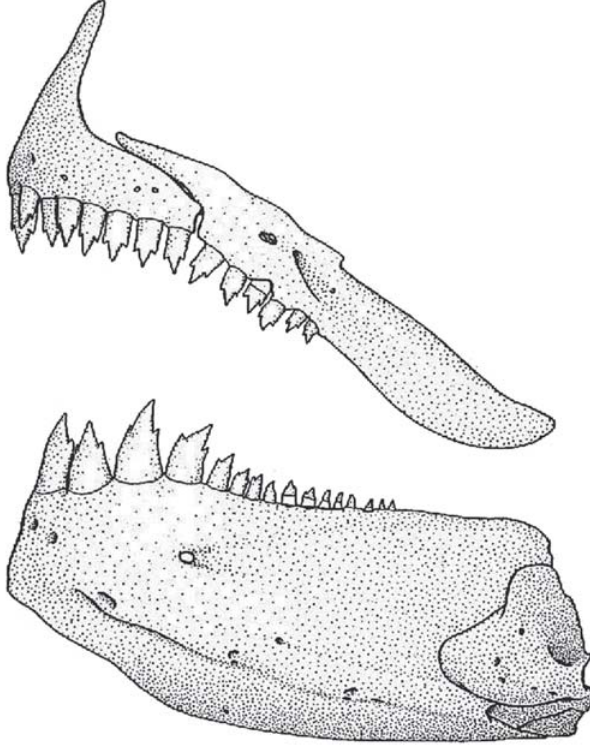
Fig. 86. Mimagoniates microlepis , adult male, USNM 249876, 59.3 mm SL; jaws and dentition, lateral view, right side, anterior at right. Compare number of maxillary teeth (10) in this specimen with that in Fig. 87 (6). Number of maxillary teeth varies considerably in specimens depending on their standard length.